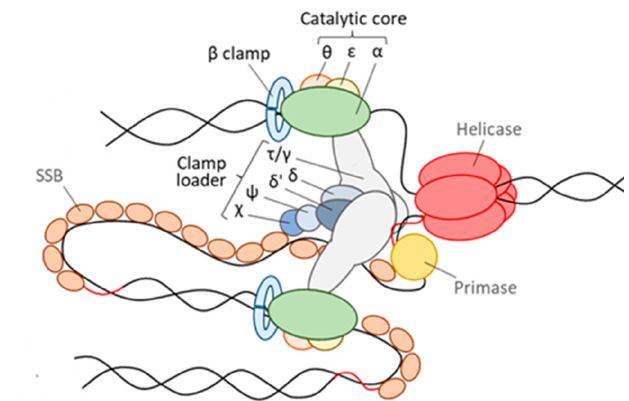
Figure 1. Schematic of the prototypical Pol III holoenzyme. The three subcomplexes of the Pol III holoenzyme, namely the catalytic core, the β clamp and the clamp loader, and their protein subunits are shown in the figure. The bacterial replisome also includes a helicase, which unwinds the double- stranded DNA (dsDNA), a primase, which synthesizes the short RNA primers (in red), and SSB proteins, which bind to and protect single-stranded DNA (ssDNA) filaments.